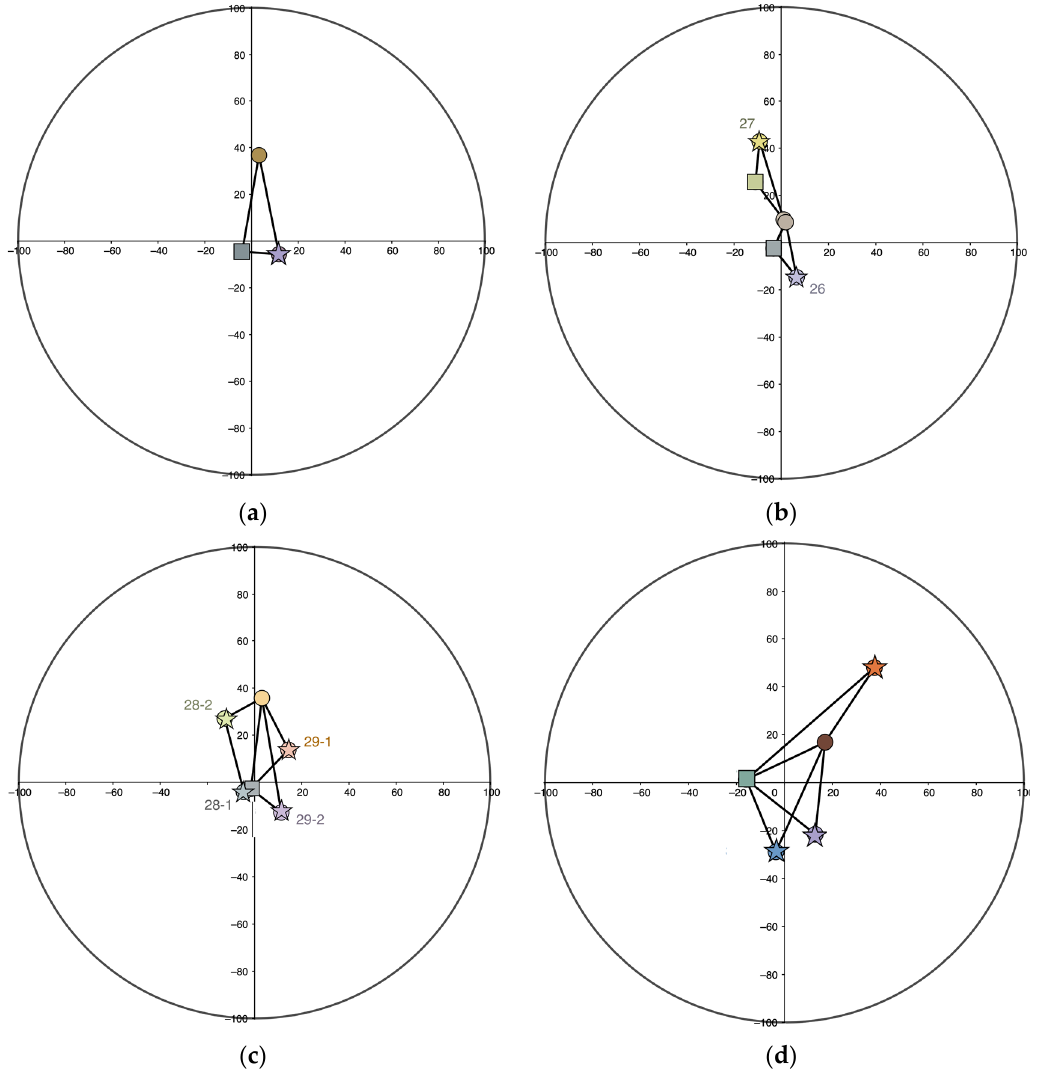
Figure 16. Hue (h°) and chroma (C) of the main (circle), background (square) and “intermediary” (star) colors in Section IV; projection into the CIELCh color circle: ( a ) Chart 25; ( b ) Charts 26 and 27; ( c ) Charts 28 and 29; ( d ) Chart 30.